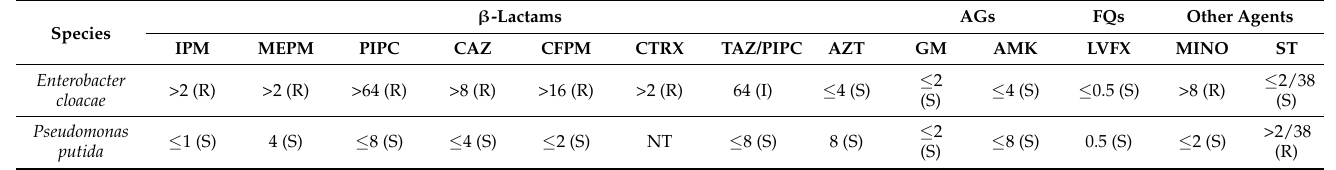
Table 1. The antimicrobial susceptibility pattern of the isolates from washbasin taps in medical